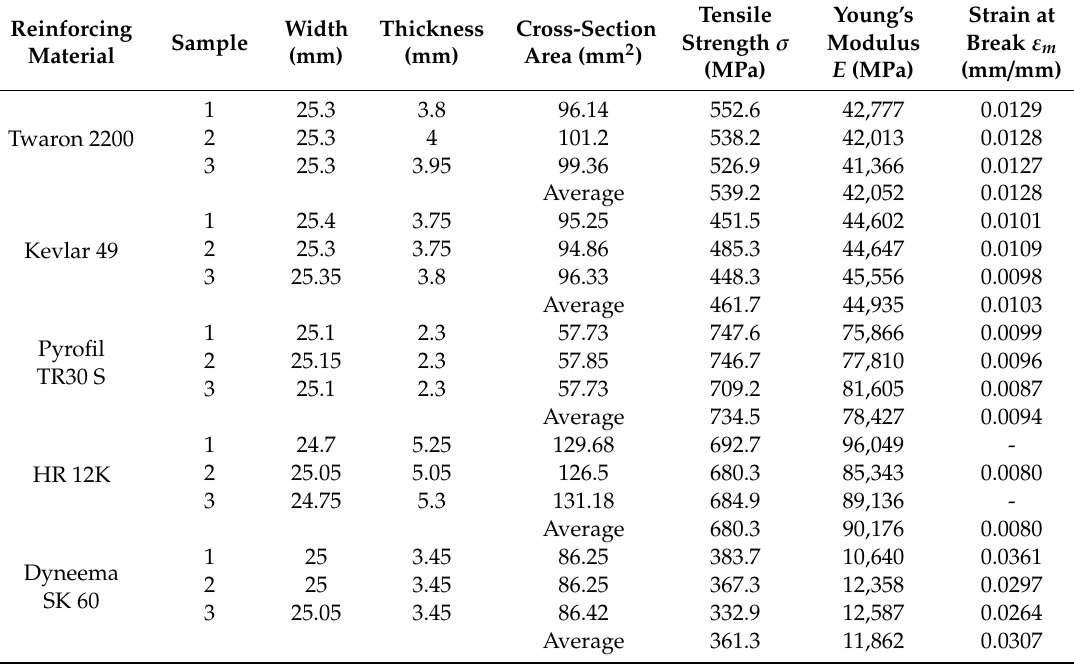
Table 6. Dimensions of the composite samples and their mechanical parameters calculated based on the conducted tensile tests.